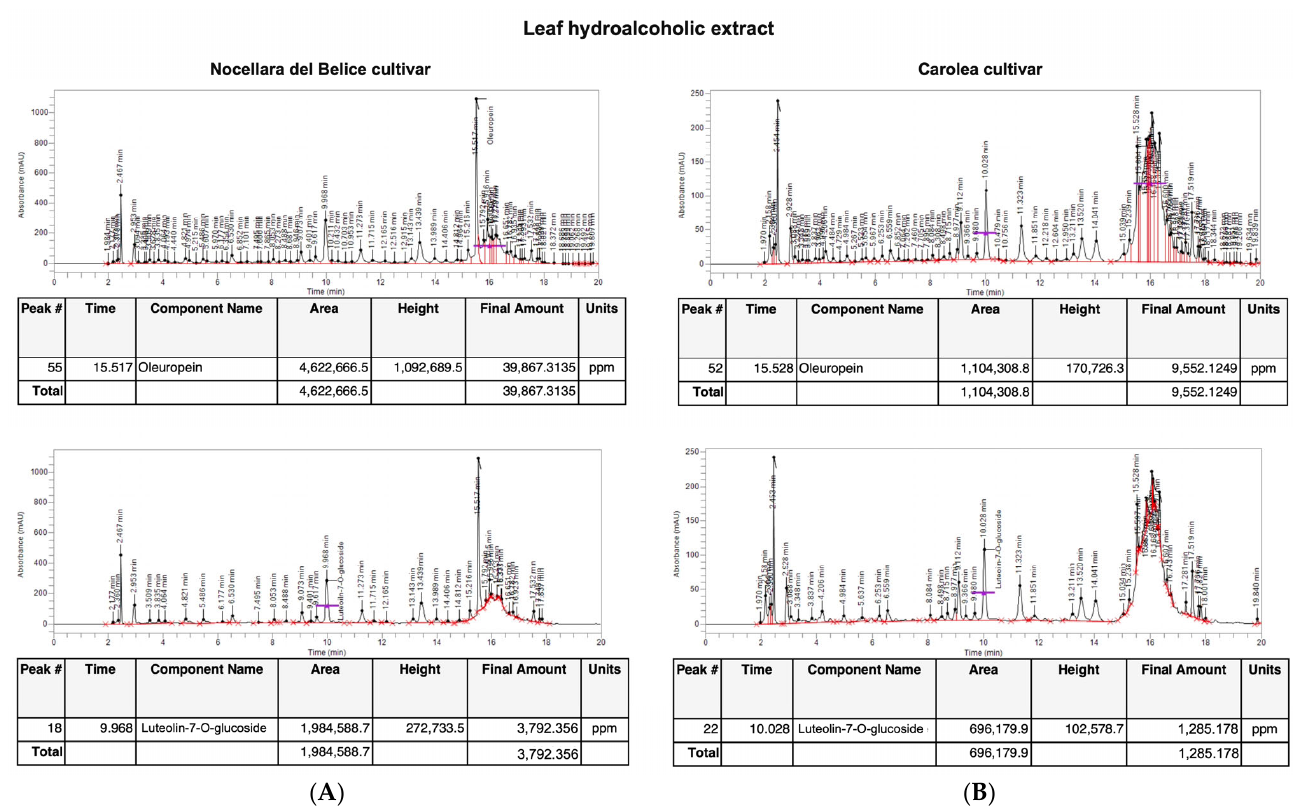
Figure 2. lHPLC analysis of O. europaea L. leaf acetone ‐ water extract. Chromatogram of HPLC analysis of O. europaea L. leaf extract for ( A ) Nocellara del Belice cultivar and ( B ) Carolea cultivar. The leaf hydroalcoholic extract from Nocellara del Belice cv. showed an oleuropein content of 39.867 mg and 3.79 mg of luteolin-7-O-glucoside compared to the hydroalcoholic leaf extract of Carolea, that highlighted an oleuropein content of 9.55 mg/g (Figure 3) and a luteolin-7-O-glucoside content of 1.29 mg/g of leaves weight (Figure 3).